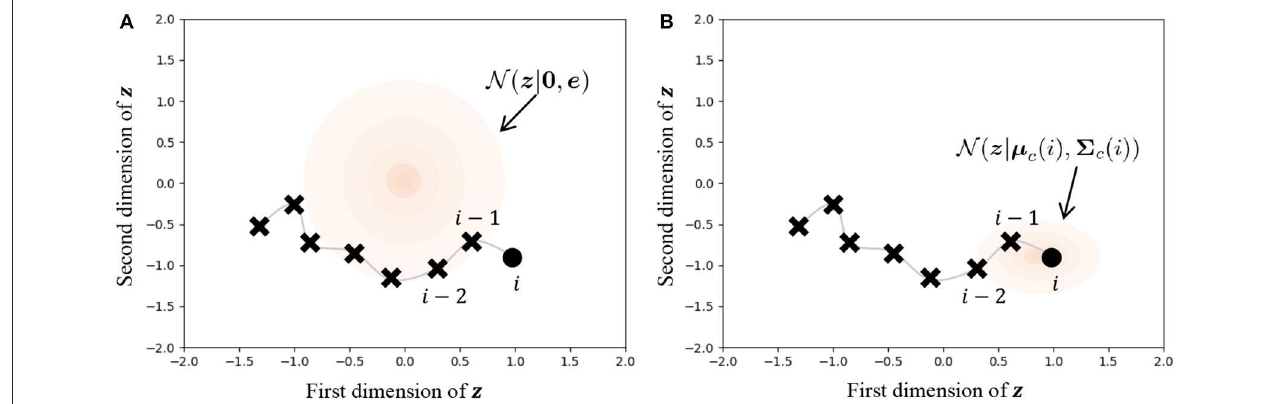
Frontiers in Robotics and AI |